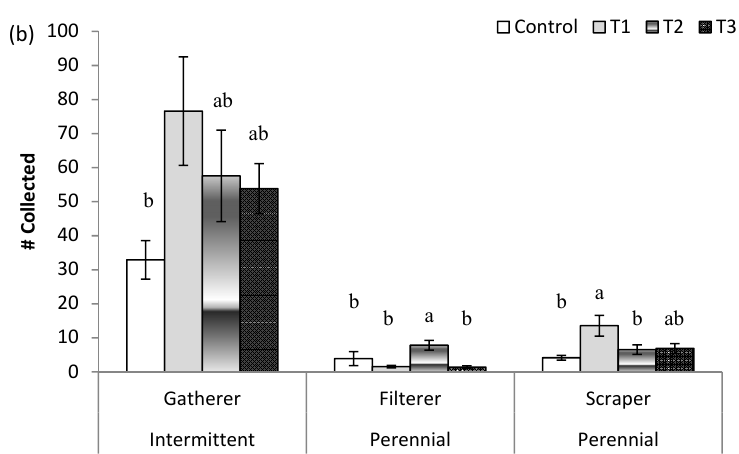
Figure 3. Post-treatment differences in benthic macroinvertebrate abundance across SMZ treatments. ( a ) Post-treatment differences in total abundance across SMZ treatments from intermittent and perennial stream segments at Robinson Forest, Kentucky (USA). Columns within each response variable which share letters are not significantly different from one another ( p < 0.05); ( b ) Post-harvest differences in functional feeding group abundance across SMZ treatments at Robinson Forest, Kentucky (USA).Columns within each response variable which share letters are not significantly different from one another ( p <